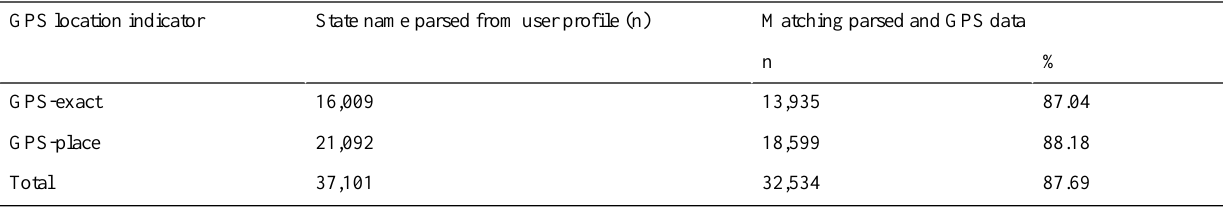
Table 3. Comparison of GPS location data to parsed location